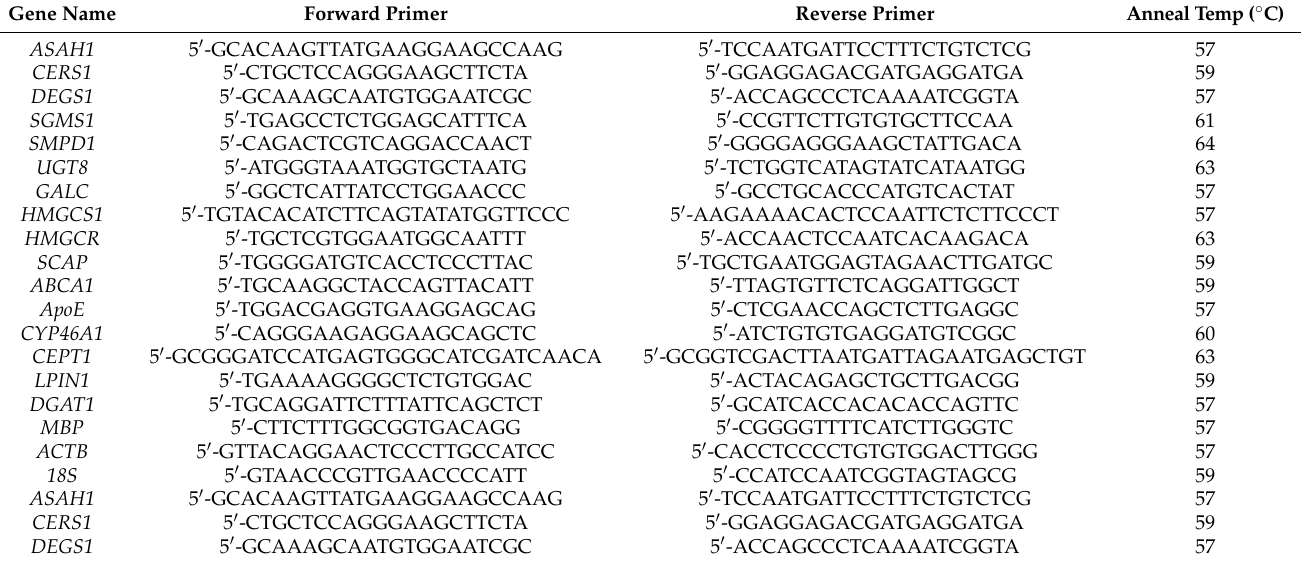
Table 2. Primers used for the qRT-PCR reactions with their optimised annealing